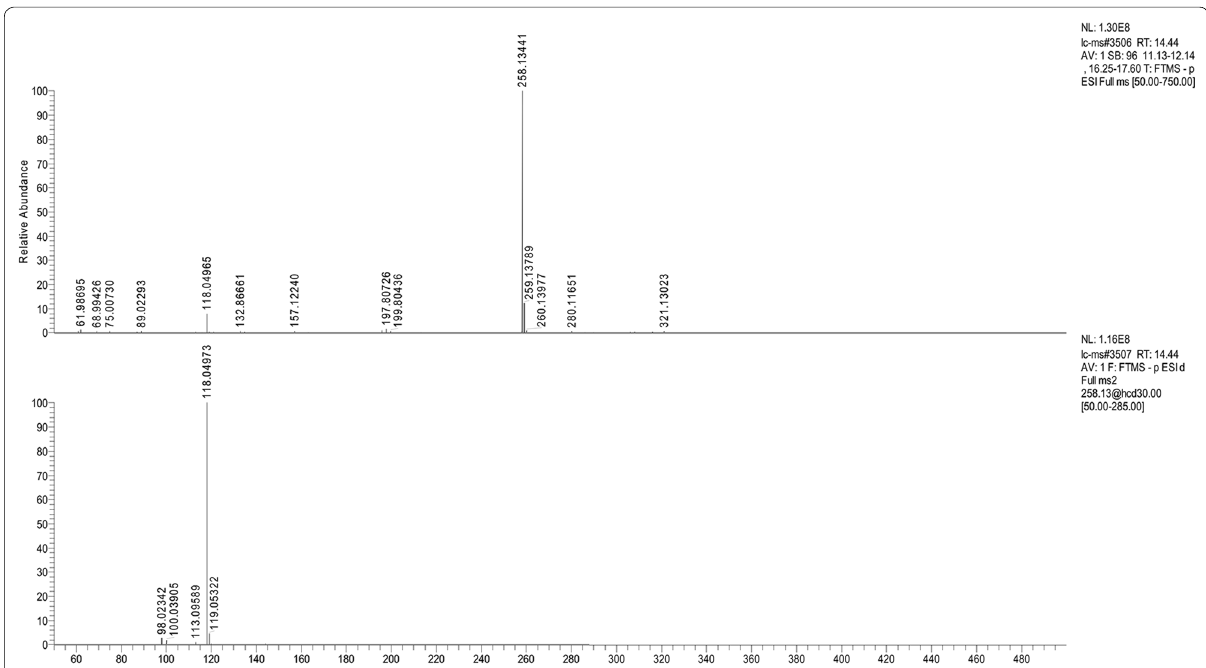
Fig. 5 LC–MS/MS analysis of the hydrolysis product of 3‑oxo‑C8‑HSL by AiiO‑AIO6. MS 1 analysis of the 14.44 min HPLC fragment of enzymatic